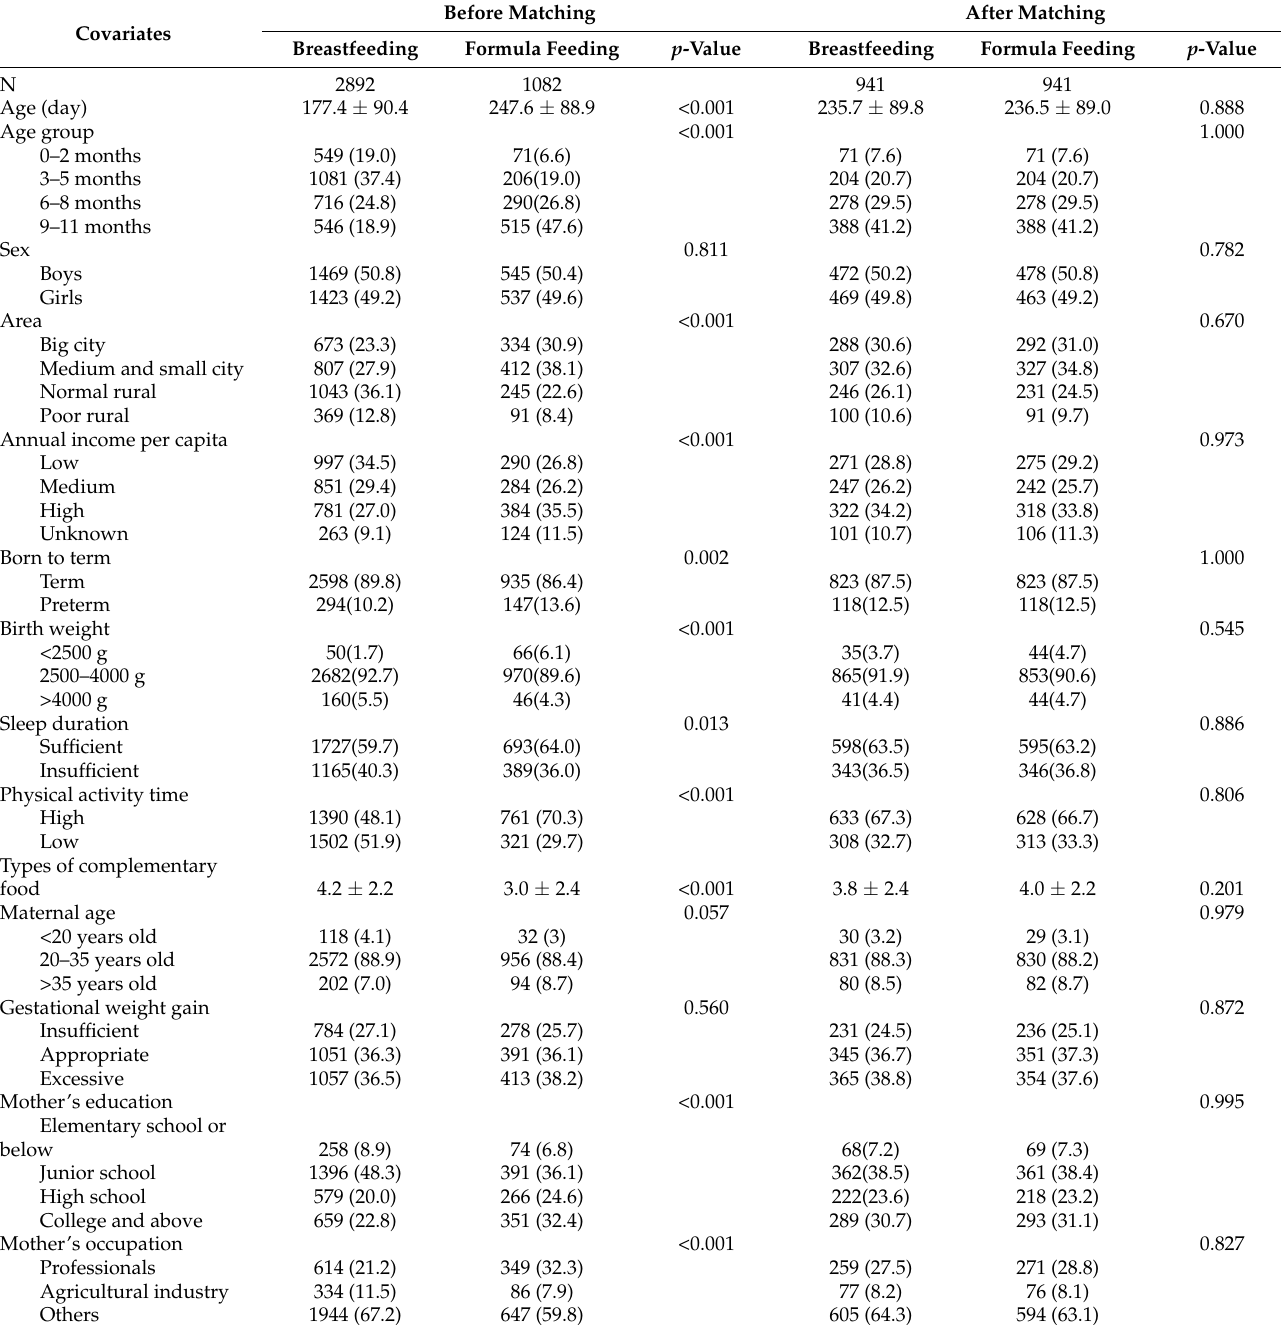
the number of formula-fed infants. Between two feeding groups, there were differences in living area, annual income per capita, whether the infant was born to term or not, birth weight, physical activity time, complementary food intake, and mother’s educational level and occupation. After propensity score matching, no significant differences were found between two groups for the matched covariates. Table 1. Infant, family, and maternal characteristics before and after matching, N (%). Before Matching After Matching Covariates Breastfeeding Formula Feeding